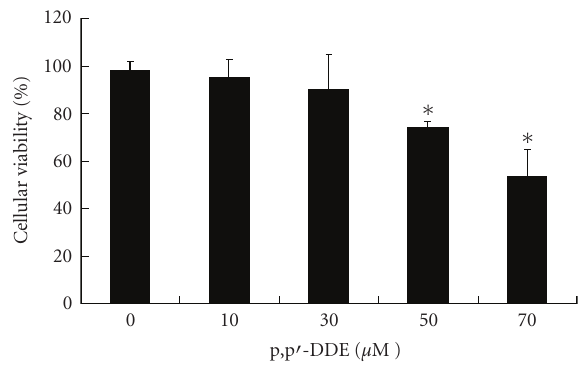
Figure 1: E ff ect of p,p (cid:2) -DDE on the viability of rat Sertoli cells with MTT assay. MTT (3-(4, 5-dimethylthiazol-2-yl)-2, 5- diphenyltetrazolium bromide) can be reduced by the mitochondrial dehydrogenase of viable cells to blue formazan product which can be measured spectrophotometrically. Cells were treated with 0 . 3% DMSO, 10, 30, 50 or 70 μ M p,p (cid:2) -DDE for 24 hours, and the optical density (OD) was measured by MTT. Cellular viability (%) was calculated using the following equation: cellular viability (%) = (OD treatment /OD control ) × 100. Significant di ff erence is ( ∗ ) P < . 05, compared with the control